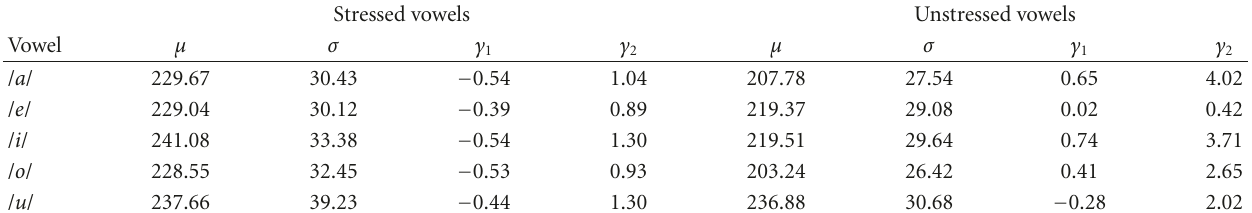
Table 5: Mean ( μ ), standard desviation ( σ ), skewness ( γ years-old).